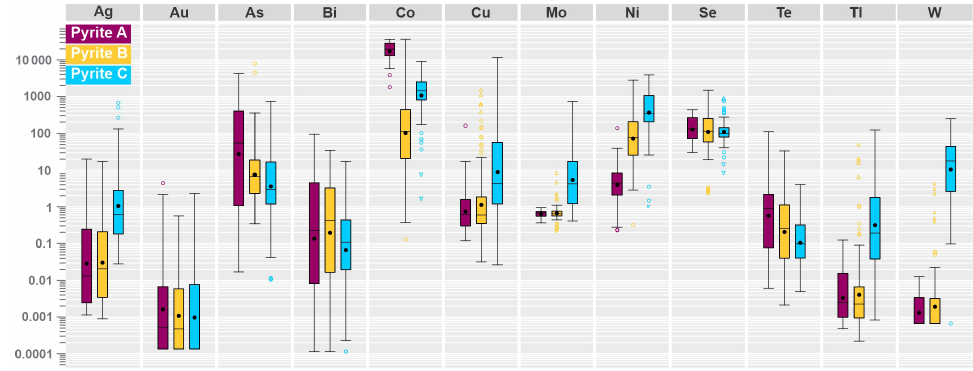
Figure 11. Logarithmic-scaled boxplot illustrating the range in concentration of metals and pathfinder elements in analyzed pyrite A, B and C by